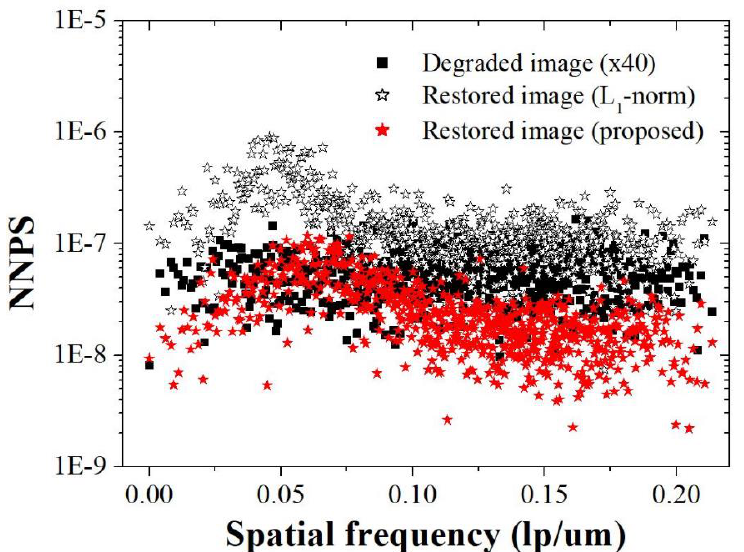
Figure 11. NNPS results (obtained using ROI B in Figure 9) of the degraded image (×40), restored image ( l 1 -norm), and restored image (proposed) at all spatial frequencies (lp/μm).